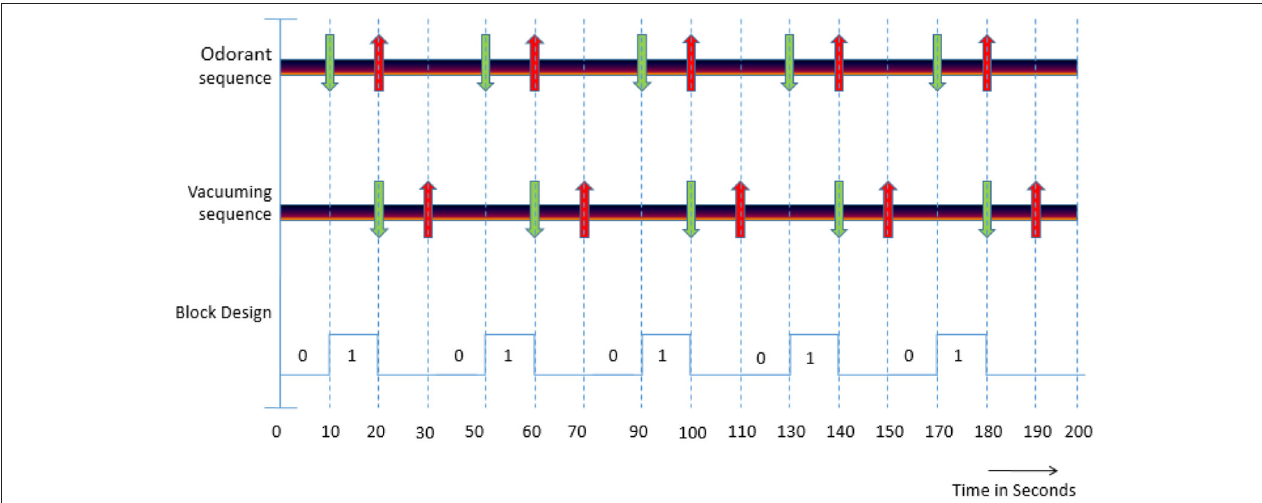
FIGURE 2 | (i) Odorant sequence: Green down arrow indicates the starting of the stimulant presentation and red up arrow indicates ending of the stimulation. (ii) Vacuuming sequence: Green down arrow indicates the starting of the vacuuming to remove odorant and the red up arrow indicates ending of vaccuuming. (iii) Block Design: “0” indicates the absence of an odorant (OFF condition) and “1” indicates the presence of an odorant (ON condition).